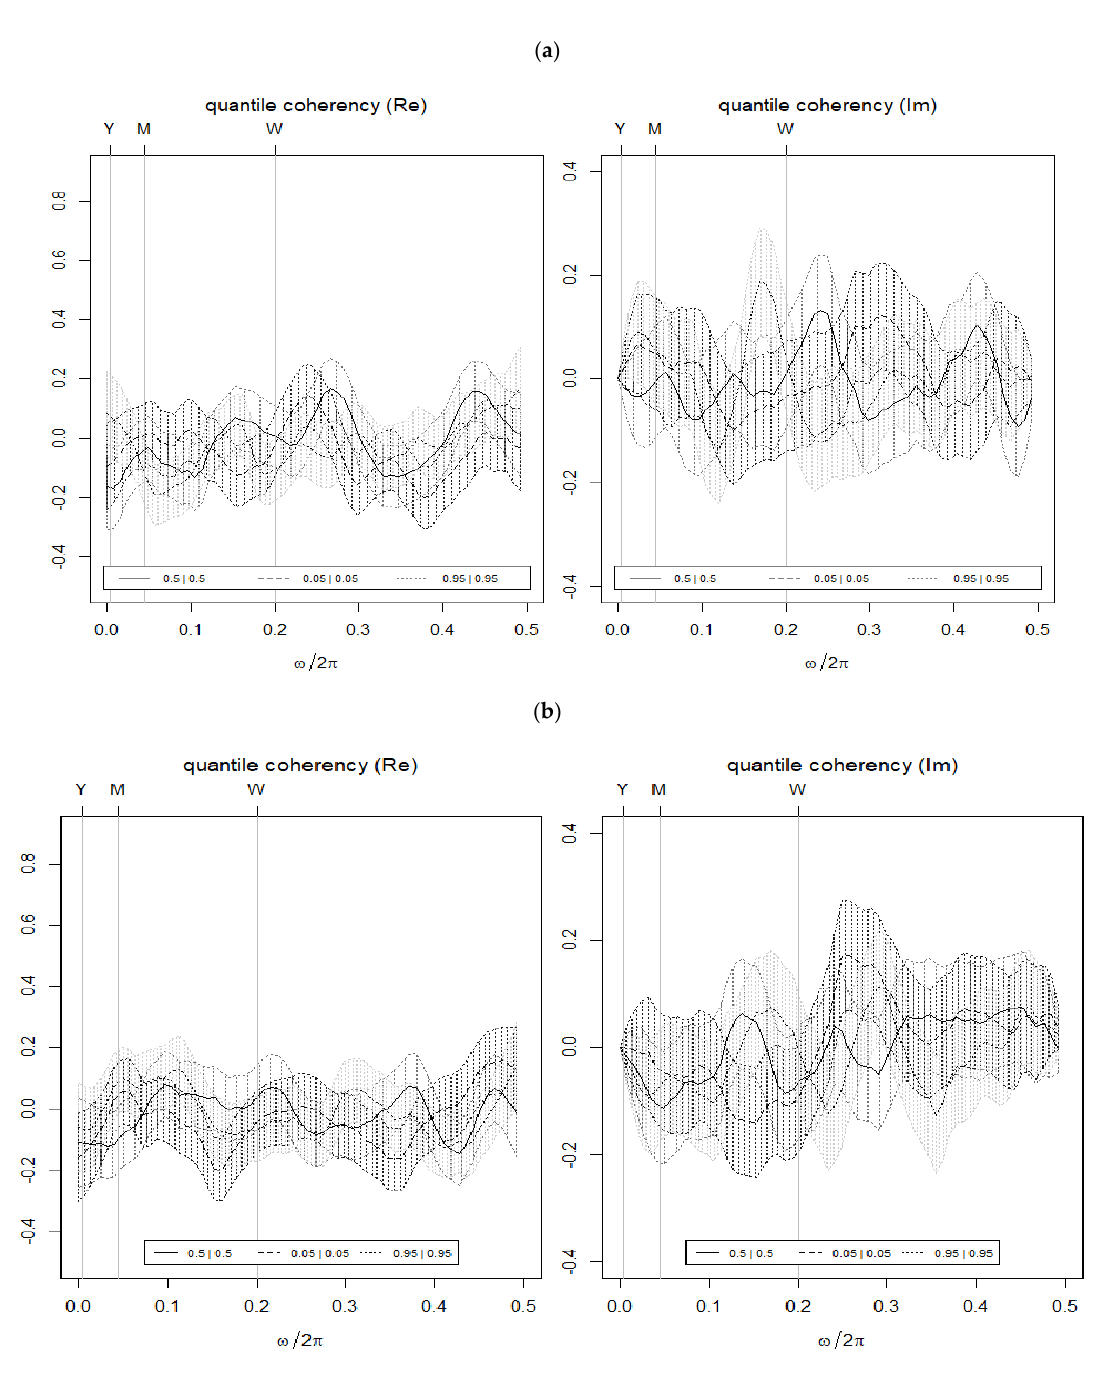
Figure 1. Quantile coherence estimates. ( a ) BTC vs. USA-EPU. ( b ) BTC vs. CHN-EPU. Notes: (i) BTC = Bitcoin; CHN_EPU = Chinese economic policy uncertainty index; USA_EPU = USA economic policy uncertainty index. (ii) The plots report the real (left) and unreal (right) parts of the quantile coherency estimates for the different lower, middle, and upper quantiles (0.05|0.05, 0.5|0.5, and 0.95|0.95) of the joint distribution across the different frequencies. The daily cycles over the intervals [0, 0.5] are shown on the horizontal axis, whereas the vertical axis measures the co-dependence of two time series. The frequency cycles in the upper label of the horizontal axis show how yearly (Y), monthly (M), and weekly (W) frequencies are connected across the joint-distribution quantiles.